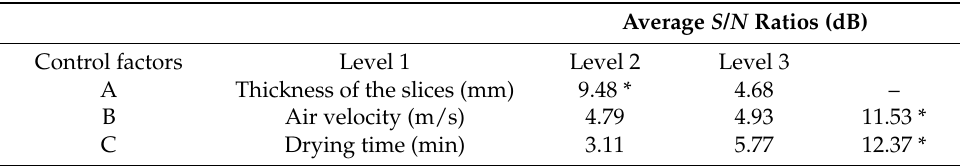
Table 4. Optimum levels of the